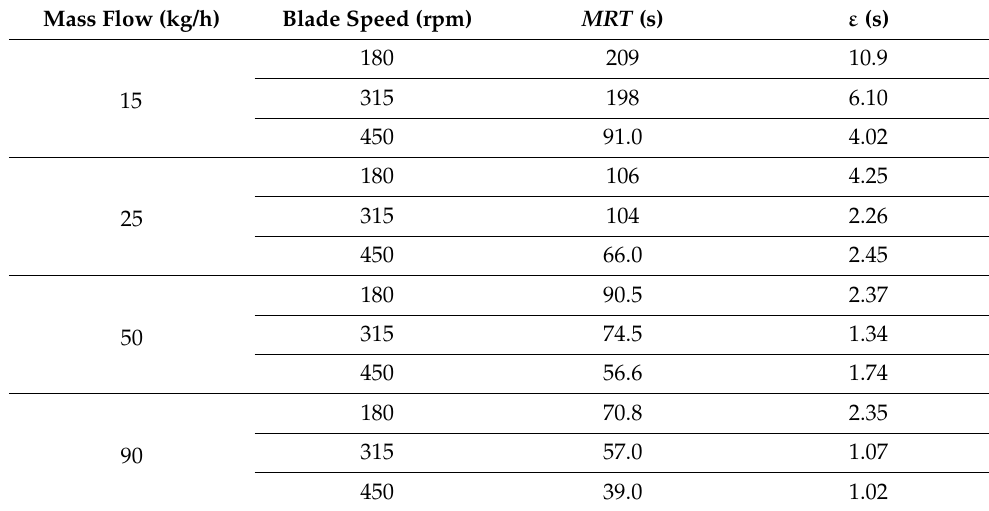
Table 2. Regressed Mean Residence Time Values and Goodness-of-Fit Values for Blender 1. Mass Flow